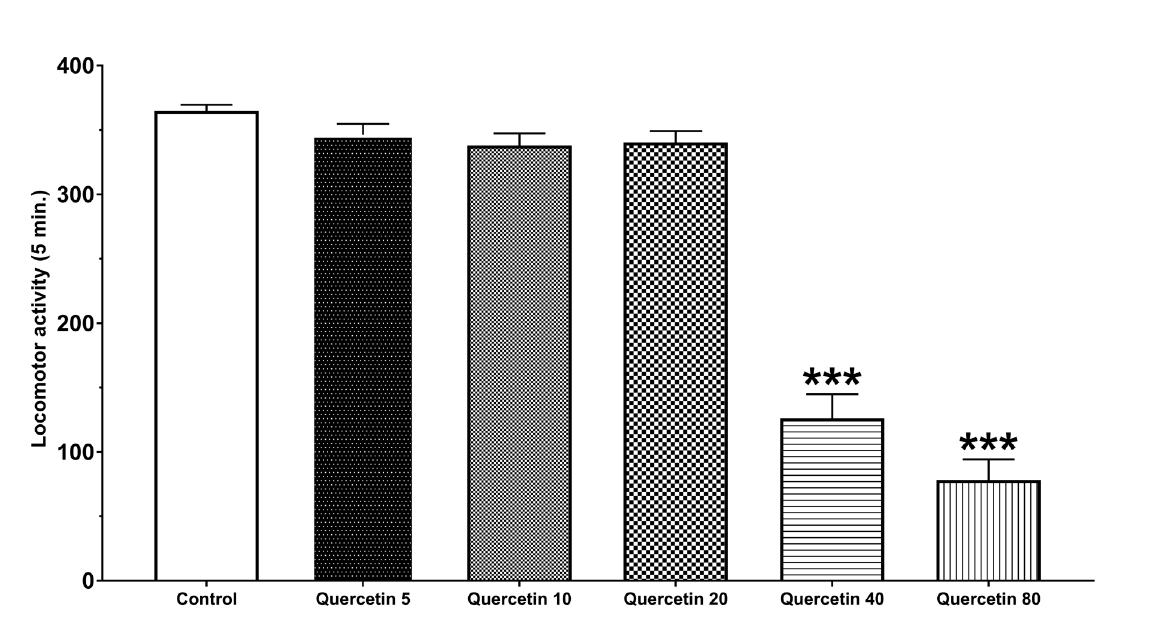
FIGURE 1 - Locomotor activity results of all experimental groups. Quercetin decreased locomotor activity at 40 and 80 mg/kg doses. All data represented as mean±SEM. ***p<0.001 versus the control